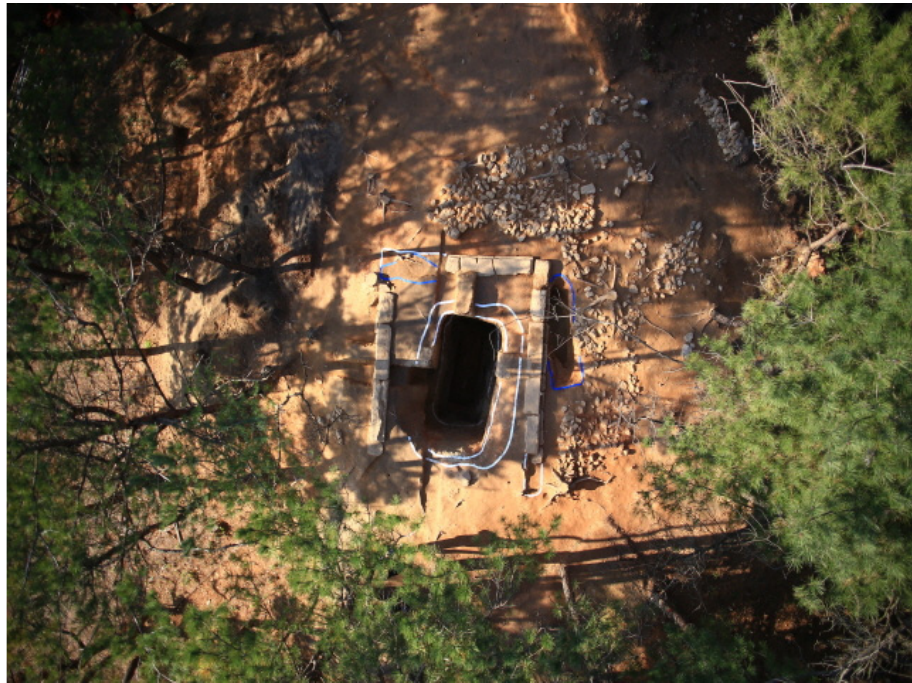
Figure 1. Aerial view of the Nongso Tomb in Ullim-ri, Sunch’ang-gun, North Ch ŏ lla Province of Korea. After (Kungnip Naju munhwajae y ŏ n’guso 2016, p. 46, Figure 9).